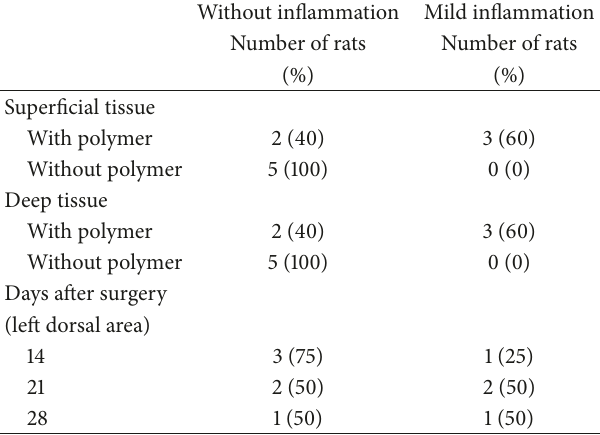
Table2:Resultsofhistologicalanalysisofsurfacetissueforthethree periods of